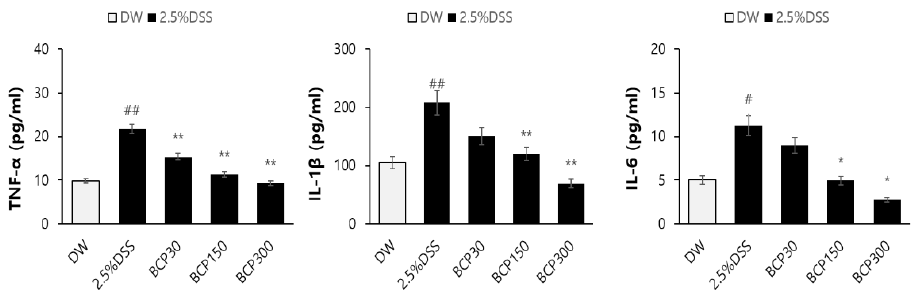
Figure 7. ELISA analysis of pro-inflammatory cytokines in mouse colons. The levels of the pro-in- flammatory cytokines, TNF- α, IL - 1β, and IL -6 were measured. Data are presented as mean ± SEM. Group comparisons were performed using unpaired t-test with post-test (#, p < 0.05; ##, p < 0.01, compared to vehicle-treated control mouse) (*, p < 0.05; **, p < 0.01, compared to vehicle-treated, DSS-induced colitis mouse).